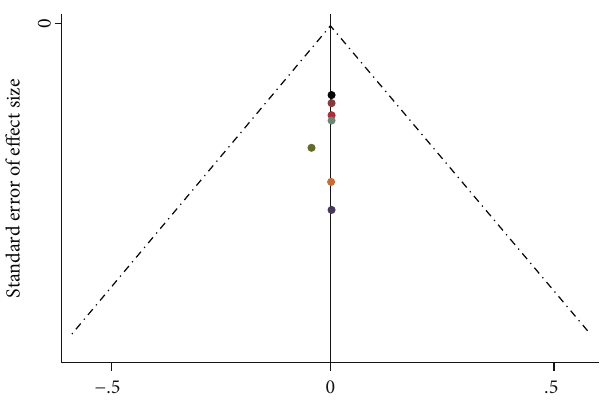
).5 −M size centred at comparison-specific pooled effect ( Y iXY XY Figure 4: Comparison-adjusted funnel plots of HOMA- β . 1: EXBID; 2: GLI; 3: EXQW; 4: insulin; 5: MET; 6: PIO; 7: SITA; 8: placebo; 9: semaglutide. Table S1: results of a random e ff ects model of HOMA-B. Table S2: results of a random e ff ects model of FBG. Table S3: results of a random e ff ects model of HbA1c. Table S4: results of a random e ff ects model of weight loss. Figure S1: evidence structure of eligible comparisons for network meta-analysis of the secondary outcomes (FBG, HbA1c, and weight loss). Figure S2: results of network meta- analysis of the secondary outcomes (FBG, HbA1c, and weight loss). Figure S3: comparison-adjusted funnel plots of the secondary outcomes (FBG, HbA1c, and weight loss). Fig- ure S4: plots of cumulative ranking probability of the second- ary outcomes (FBG, HbA1c, and weight loss). Figure S5: the contribution plots of included studies. Figure S6: node- splitting plots of outcomes. (Supplementary Materials) Figure 5: Plots of cumulative ranking probability of HOMA- β . 1: EXBID; 2: GLI; 3: EXQW; 4: insulin; 5: MET; 6: PIO; 7: SITA; 8: placebo; 9: